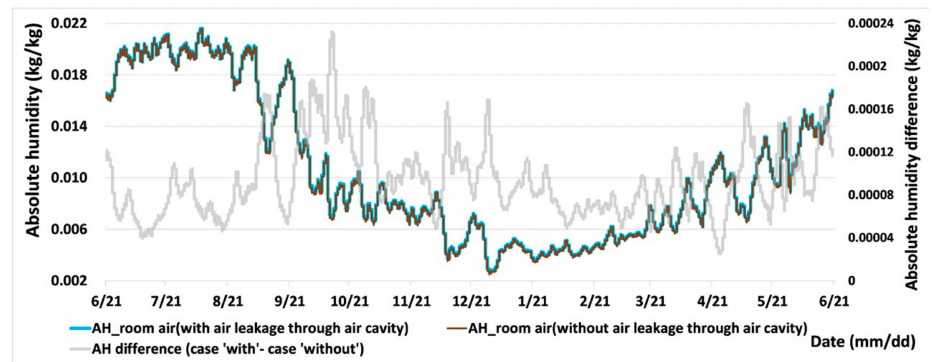
Figure 22. Calculated absolute humidity of the room air in the cases with / without air leakage through air cavity and the absolute humidity di ff erence between both